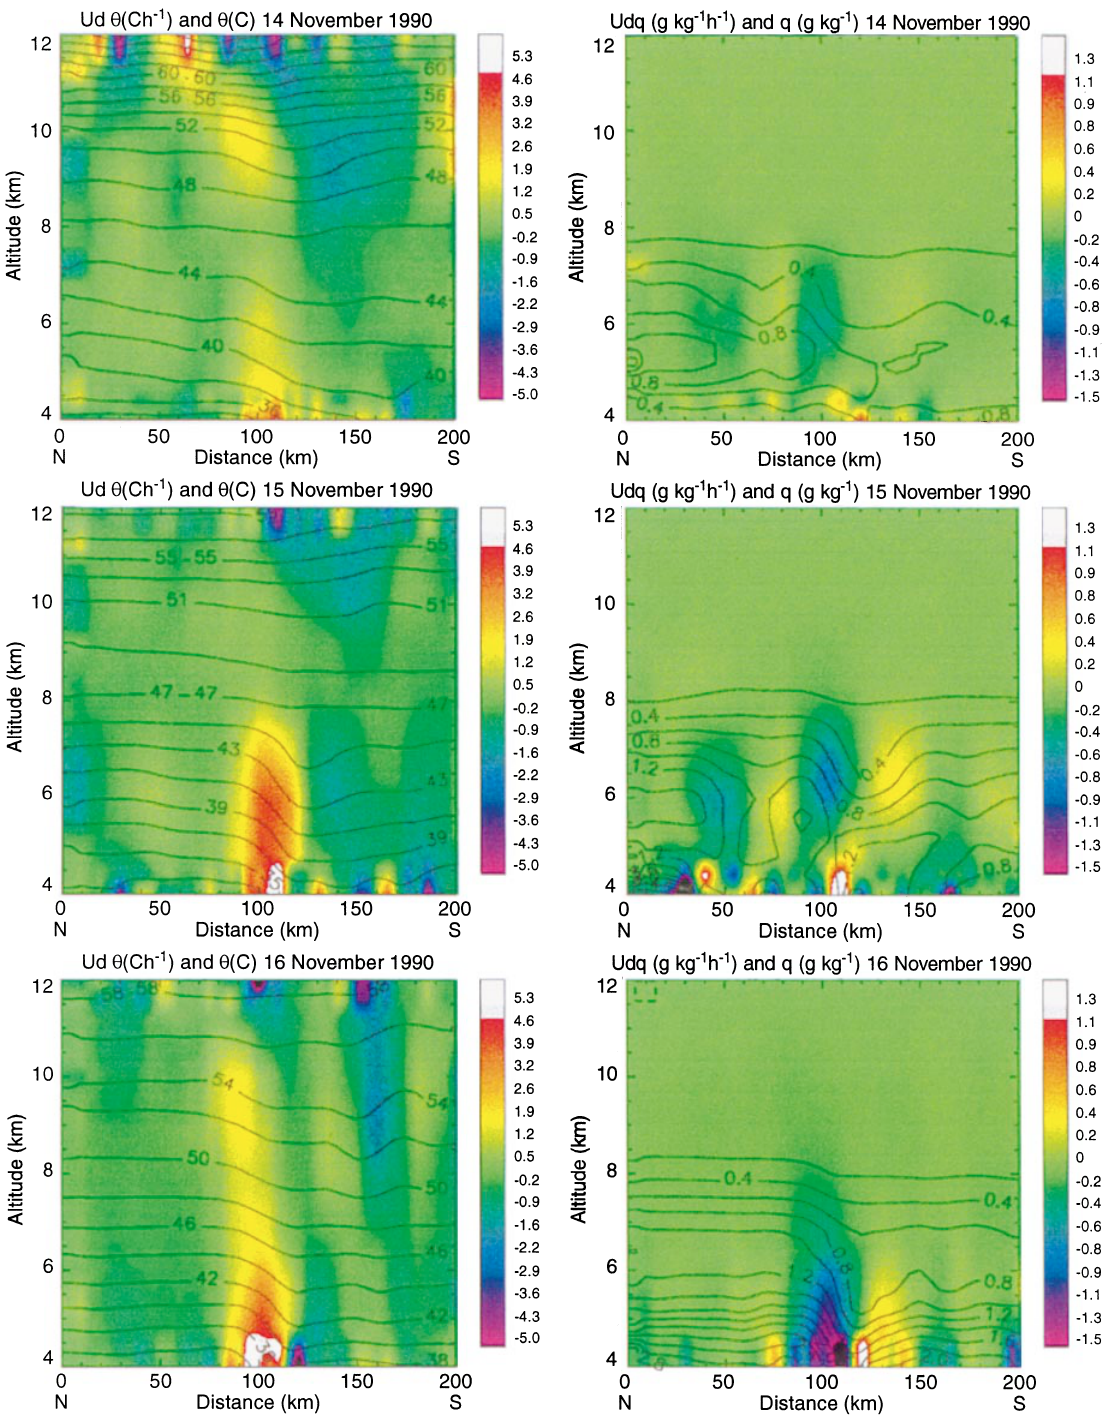
Fig. 17. Left : horizontal advection of potential temperature ( colors ) (in (cid:14) C h (cid:255) 1 ) superimposed on isentropes ( black isolines ) (in (cid:14) C); right : horizontal advection of specific humidity ( colors ) (in g kg (cid:255) 1 h (cid:255) 1 ) superimposed on moisture field ( black isolines ) (in g kg (cid:255) 1 ); from top to bottom : examples of 14, 15 and